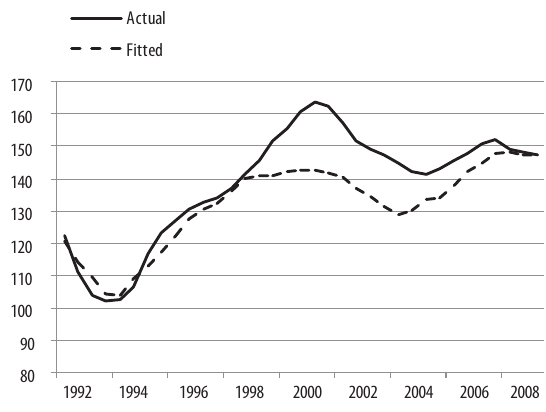
Fig. 9. Actual values of office rent index and fitted values based upon model